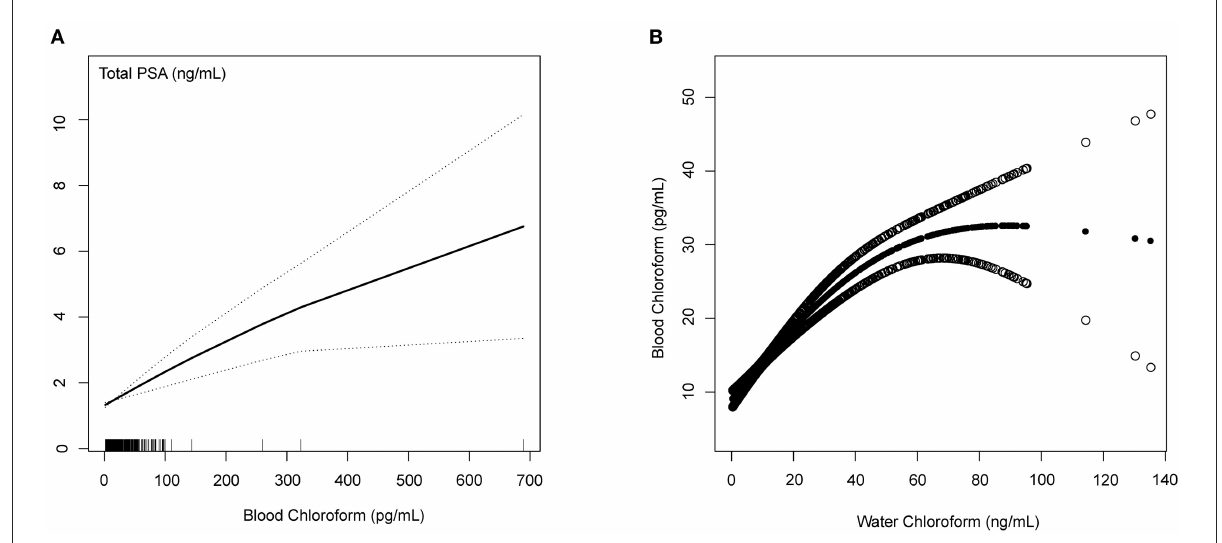
FIGURE3 Blood Chloroform and PSA concentrations/Water Chloroform (A) The linear relationship between the blood chloroform and total PSA; (B) The nonlinear relationship between the blood chloroform and water